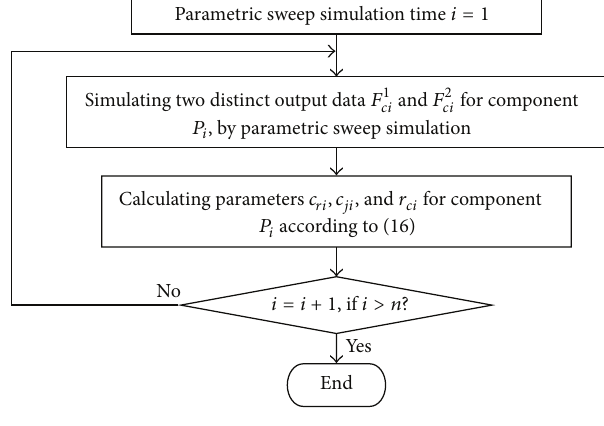
Figure 1: Flowchart of fault modeling.